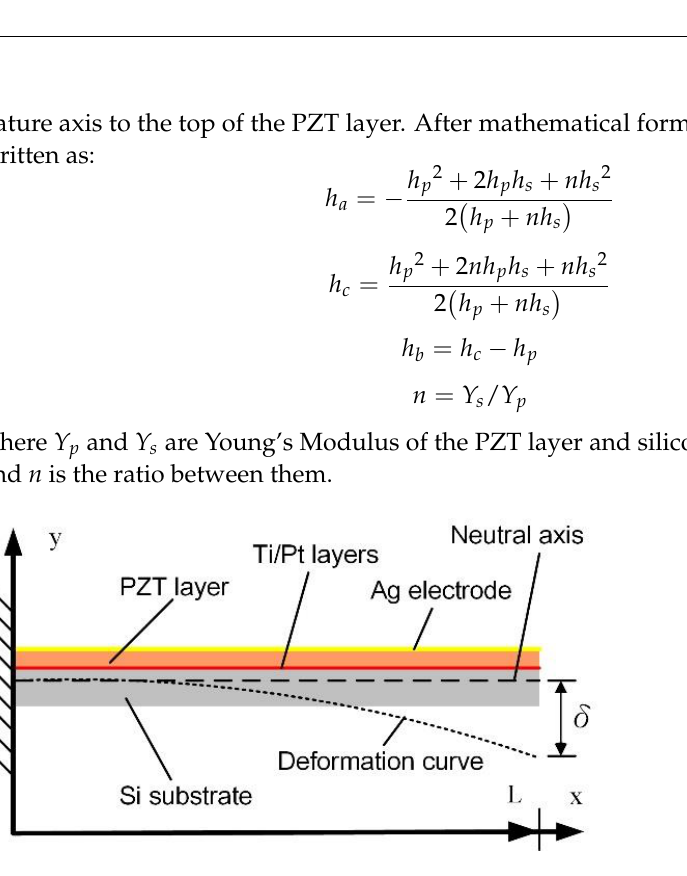
Figure 3. Schematic diagrams of the electromechanical model of the piezoelectric composite cantilever beam.